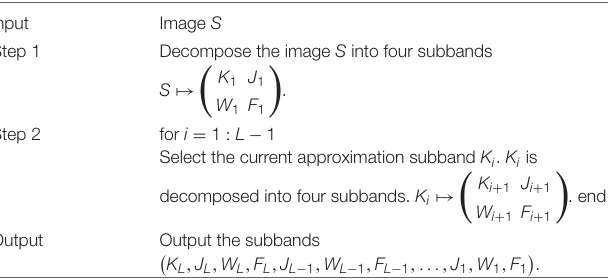
Algorithm 1 Pseudocode of